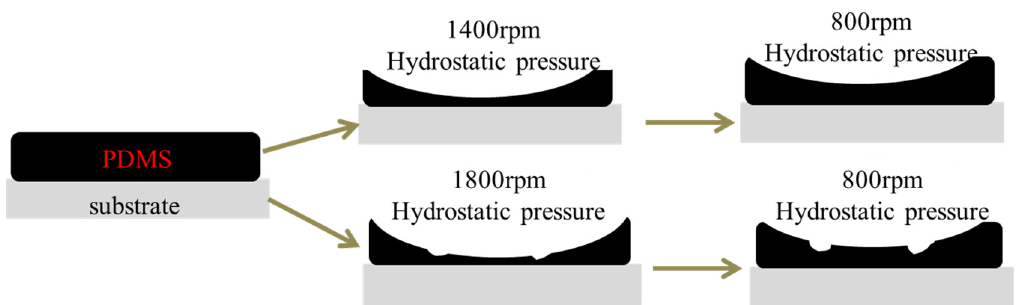
Figure 13. Schematic diagram of surface deformation of the coating.